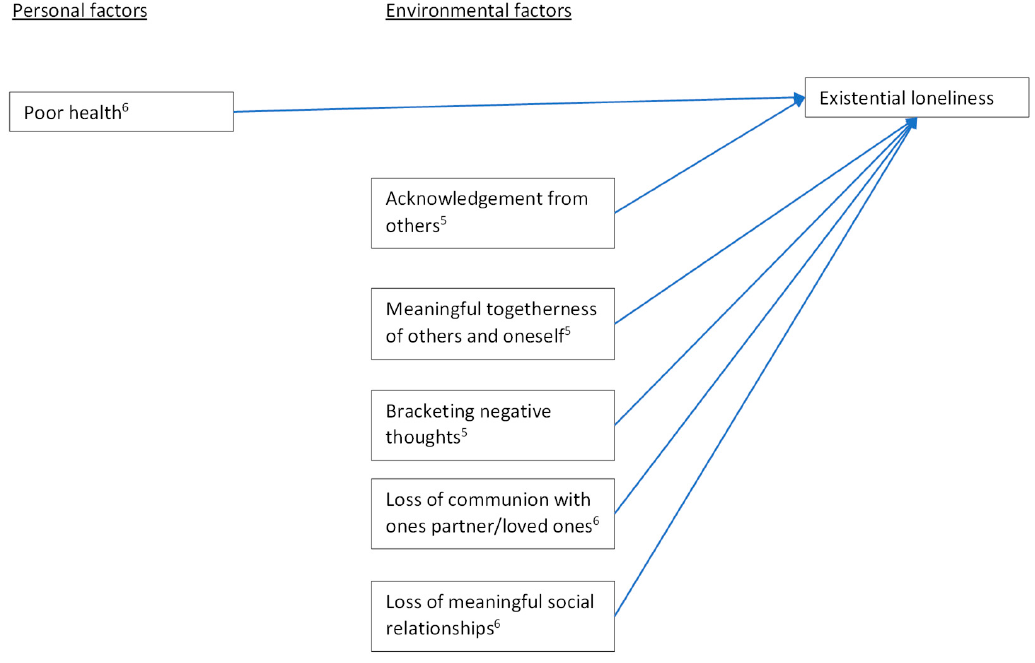
Figure 4. Antecedents to existential loneliness. 5. Sjöberg et al. (2019); 6. Hemberg et al. (2019).